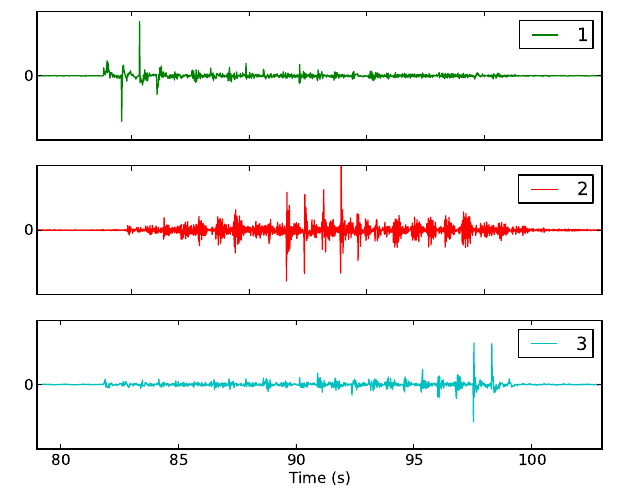
Fig. 23: Location of the 9 deployed nodes